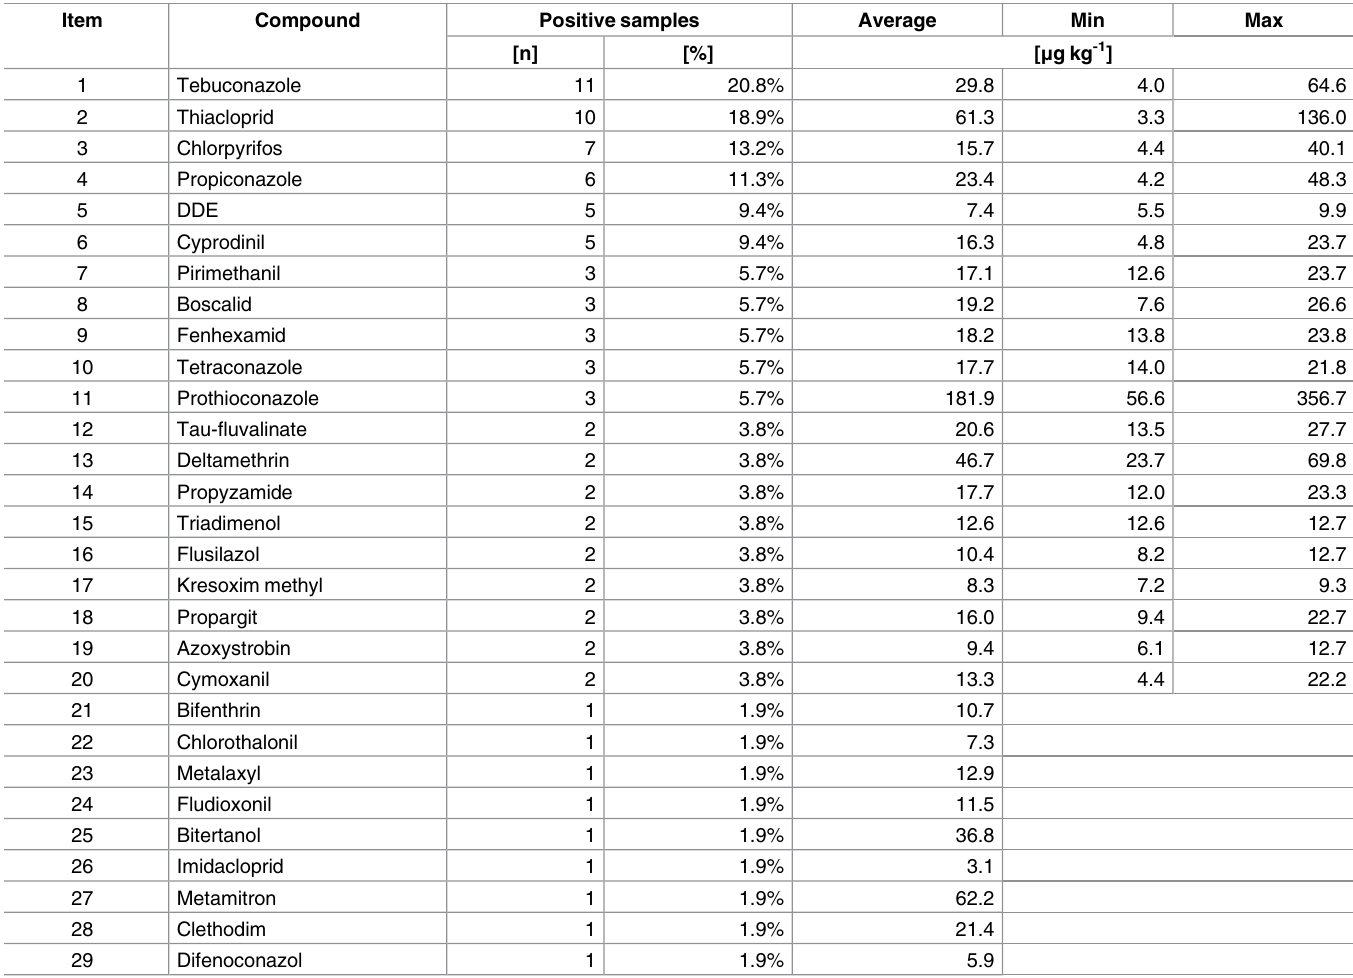
Table 2. Breakdown of pesticides found in the analyzed bee pollen samples (sorted in descending order by the number of positive